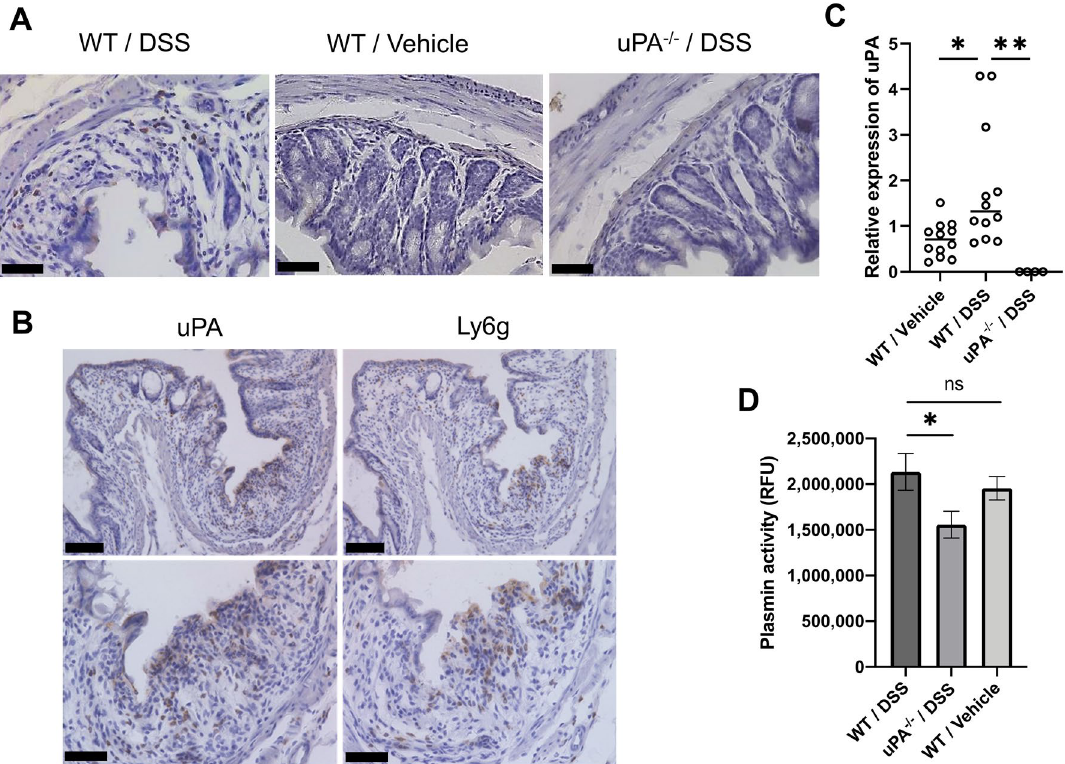
Figure 4. uPA expression and plasma plasmin activity of DSS-treated WT and uPA −/− mice. ( A ) Immunohistochemistry for uPA was performed using colorectal tissues from DSS-treated or vehicle-treated WT mice and DSS-treated uPA −/− mice (n = 3 per treatment group). The sections of colitis tissue were incubated with anti-uPA antibody, subsequently with polymer reagent and visualized using DAB chromogen. Scale bar, 50 μm. ( B ) Immunohistochemistry for uPA and Ly6g was performed using mirror sections from DSS-treated WT mice as described in the Materials and Methods. Scale bar, 100 μm (upper panel), 50 μm (lower panel). ( C ) Levels of uPA mRNA in colorectal tissue of DSS-treated (n = 12) or vehicle-treated (n = 12) WT mice and DSS-treated uPA −/− mice (n = 4) were measured by real-time PCR. Each bar represents the median value. * p < 0.05, ** p < 0.01 by Dunn’s multiple comparison test. (D) Plasmin activity in DSS-treated WT (n = 9) or uPA −/− (n = 6) mice and vehicle-treated WT mice (n = 6) was measured using SensoLyte Ⓡ AFC Plasmin Activity Assay Kit Fluorimetric. Data represent mean ± SEM. * p < 0.05 by Student’s t